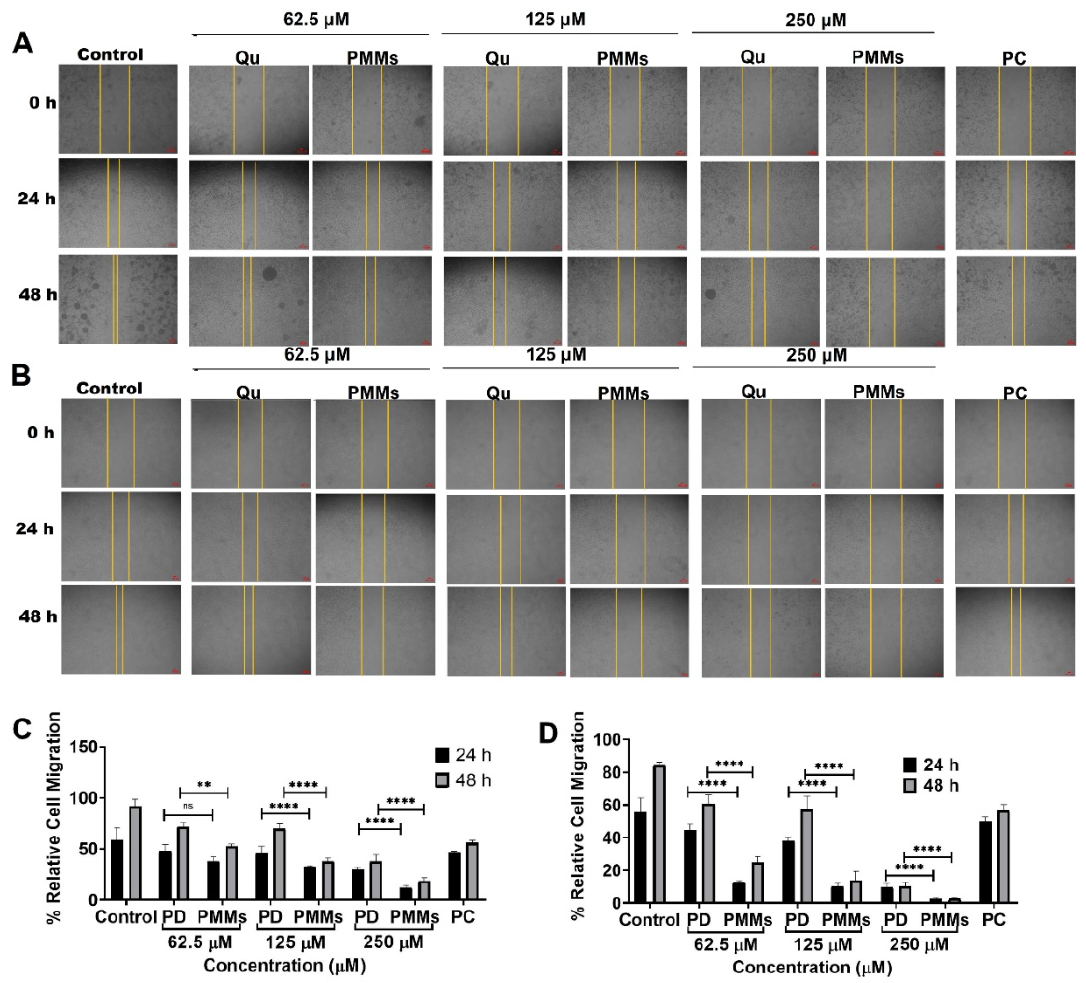
Figure 4. C6 and U87MG cells migration assay. ( A ) Pictorial representation of morphological changes of U87MG ( A ) and C6 ( B ) cells on the treatment of Qu and Qu-PMMs; The graphical representation of % relative cell migration of U87MG ( C ) and C6 ( D ) cells treated Qu and Qu-PMMs time (0 h, 24 h, and 48 h) and dose (62.5, 125, and 250 µ M) dependent migration study by wound healing assays. Data are represented in means ± Standard deviation ( n = 3). ns Indicates non-significant, ** represents p < 0.01, and **** denotes p < 0.0001 (Qu PD vs. Qu-PMMs). Scale bar ( A , B ) (4 × ) 100 µ